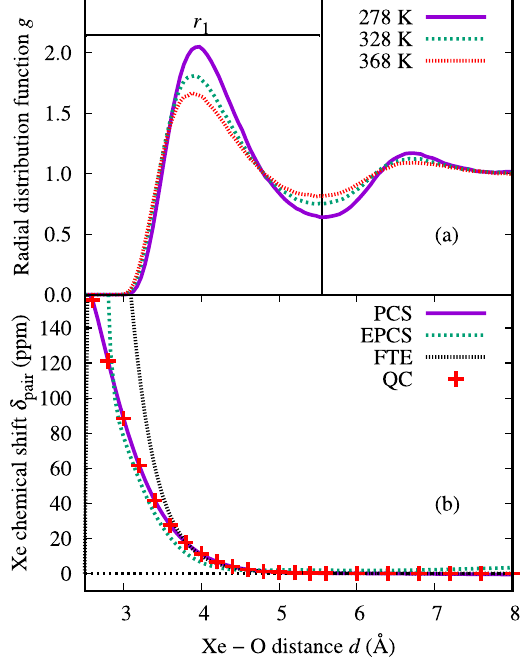
Figure 3. ( a ) Radial distribution functions (RDFs) g ( d ) for the Xe–O pairs simulated at temperatures 278 K, 328 K, and 368 K using a bin size of 0.05 Å, and ( b ) the xenon chemical shift δ pair for the Xe–H 2 O dimer. Here, r 1 corresponds to the distance to the first minimum of the RDF, i.e ., the upper limit to the radius of the first solvation shell. In panel ( b ), the PCS and EPCS approaches (see the Supplementary Information for details) correspond to a strictly binary and effective pair chemical shift functions, respectively. FTE (fit to experiment) is the result of parameterizing the semianalytical model to experiment. QC stands for the binary first-principles data that constitute the pairdata δ function, averaged as in Eq. (S13) in the Supplementary